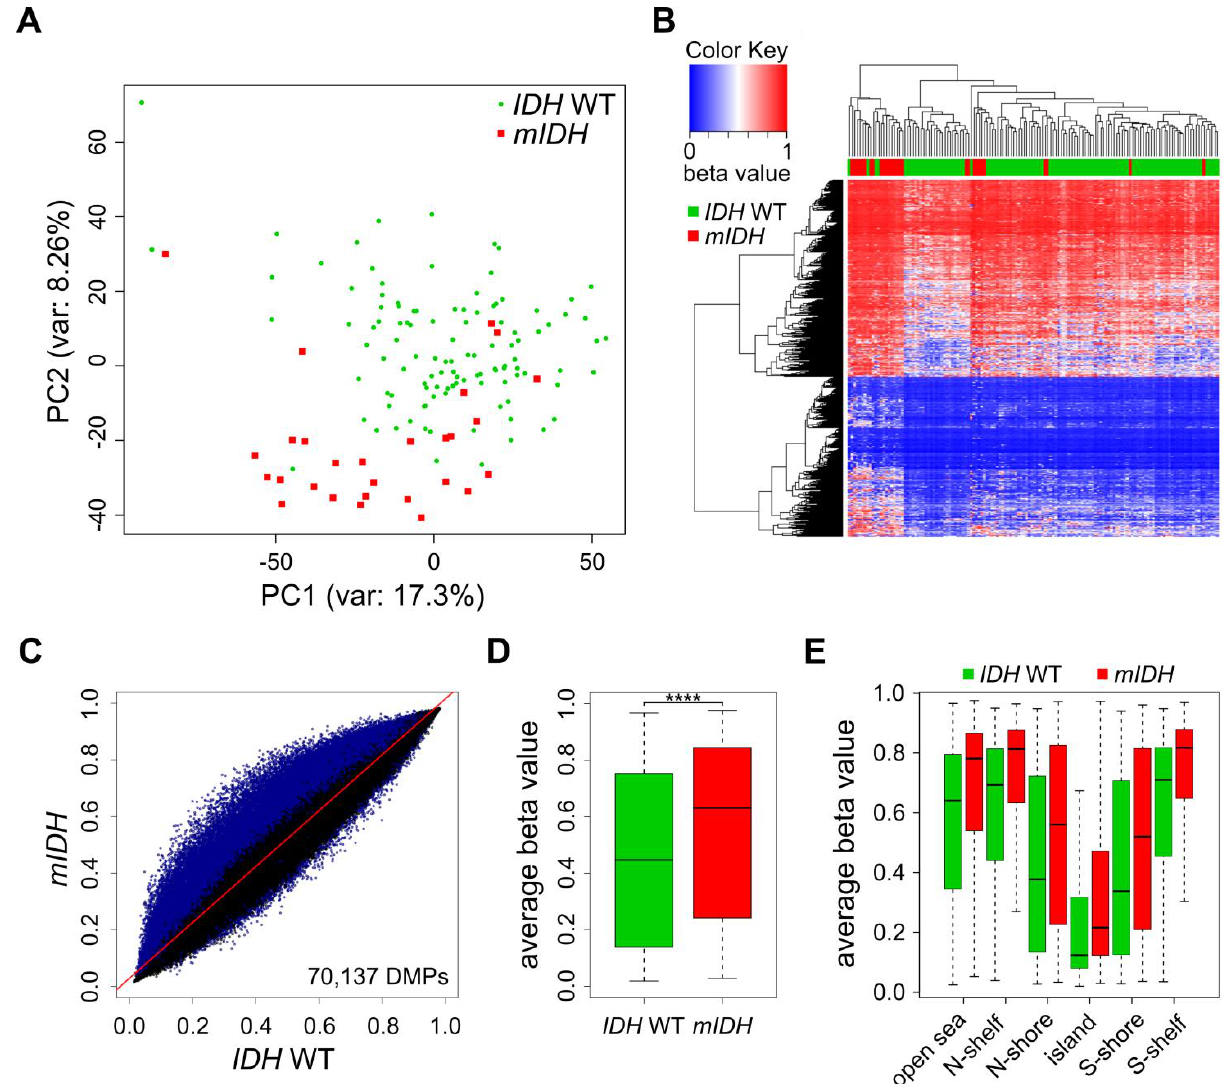
FIGURE 1: AML patients with mIDH display genomic hypermethylation. (A) Principal Component Analysis of methylomes of 28 AML pa- tients with mIDH and 112 AML patients with IDH WT status using all 450K probes retained after quality filtering. (B) Heatmap of the 5000 most significantly (adj. P <0.05) differentially methylated 450K probes between the two patient groups. Each column represents one patient and each row one probe. Dendrograms of patients and probes were obtained using hierarchical clustering by similarity. The color scale indi- cates beta values. (C) Scatterplot of the beta values of all 450K probes comparing mIDH to IDH WT patients. Each probe retained after quali- ty filtering is represented by a dot, with significantly (adj. P <0.05) differentially methylated probes (DMPs) depicted in blue. (D) Boxplot showing the average beta values of all the significantly differentially methylated probes in the two groups. The difference between the two groups was highly significant (**** P <0.0001). (E) Boxplot showing the average beta values of the significantly differentially methylated probes associated with different epigenomic features in mIDH and IDH WT patients. All differences observed between the two patient groups were highly significant ( P